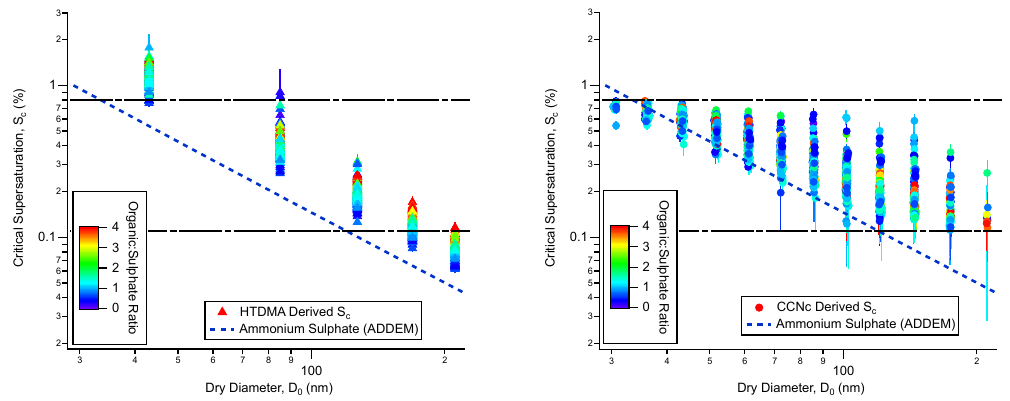
Fig. 6. Left panel: a graph showing S c , GF vs. D 0 , coloured according to organic:sulphate ratio. Right panel: a graph showing S c ,D coloured according to organic:sulphate ratio. The black dashed line represents the upper and lower values of the supersaturation setting of the